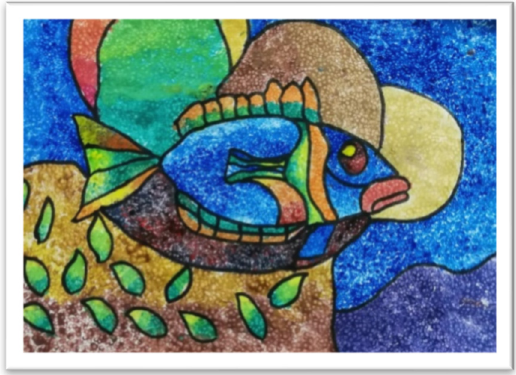
Figure 2. Student’s painting pointillism (inspired by Vaco Baissac).